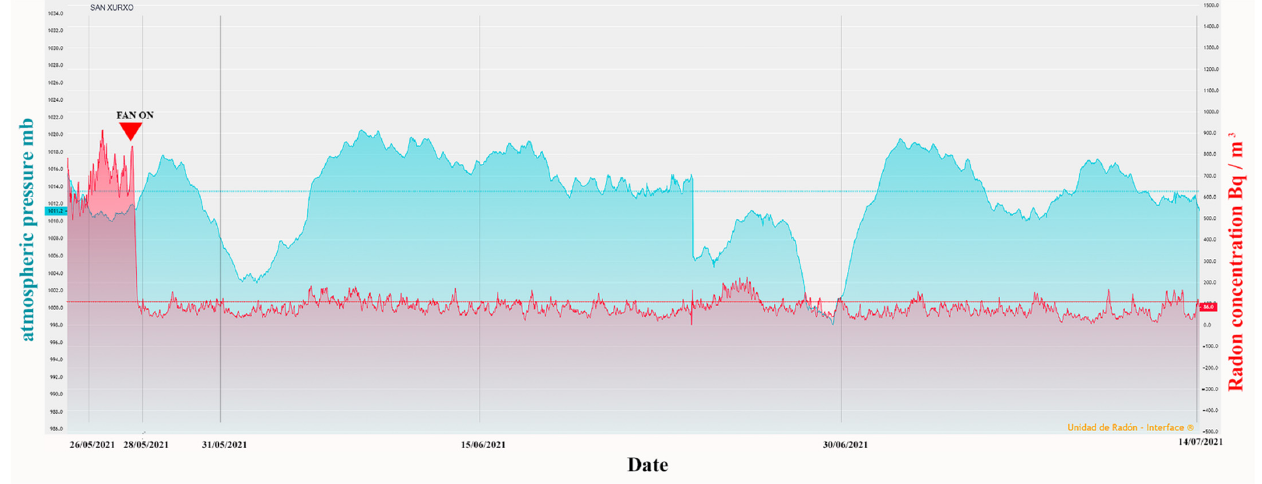
Figure 5. Graph of radon concentration from 26 May 2021 to 14 July 2021.